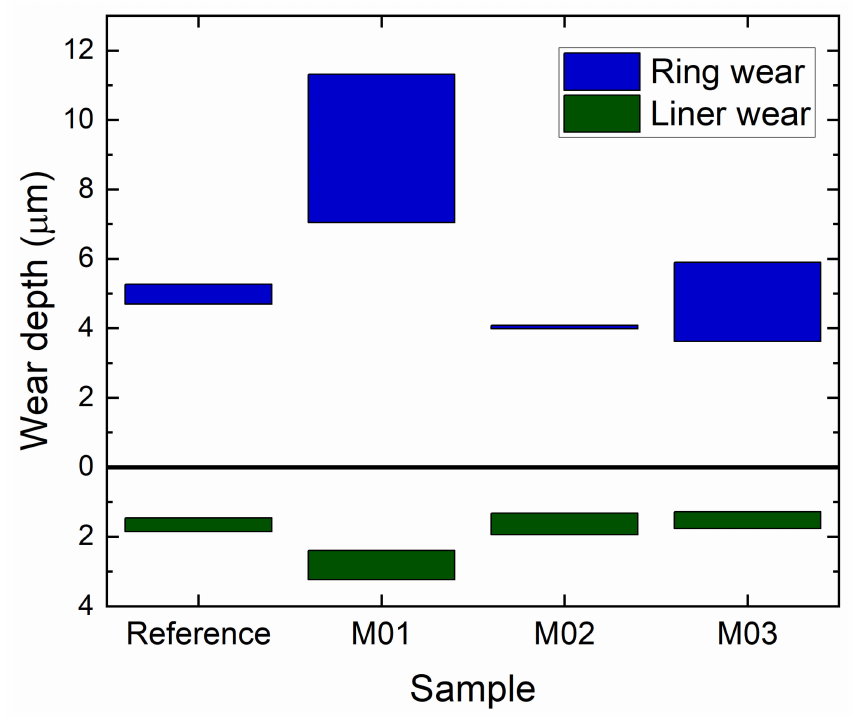
Figure 8. A comparison of the wear depth in the multilayers and coating after the reciprocating wear test, showing a better performance for the M02 deposition